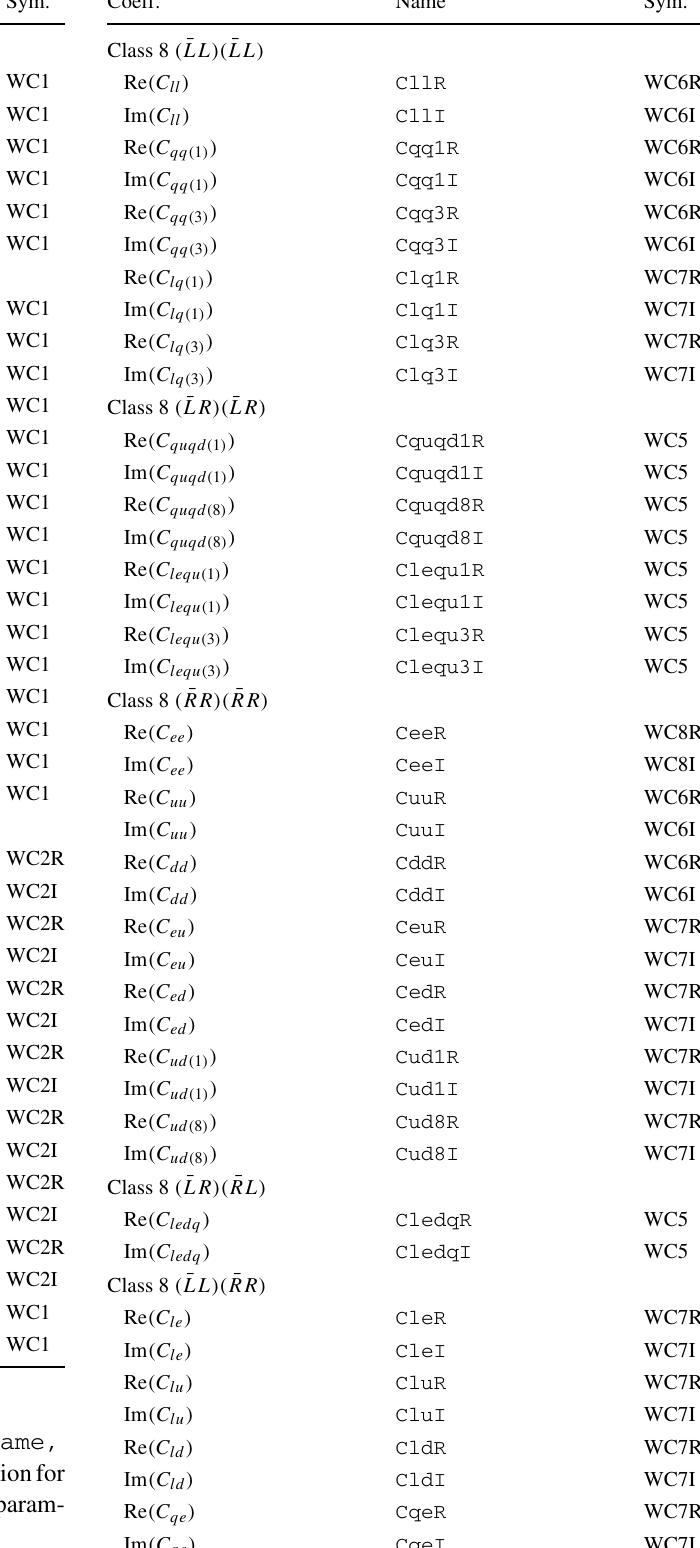
Table 8 SMEFT coefficients with four flavour indices in RGESolver Coeff.